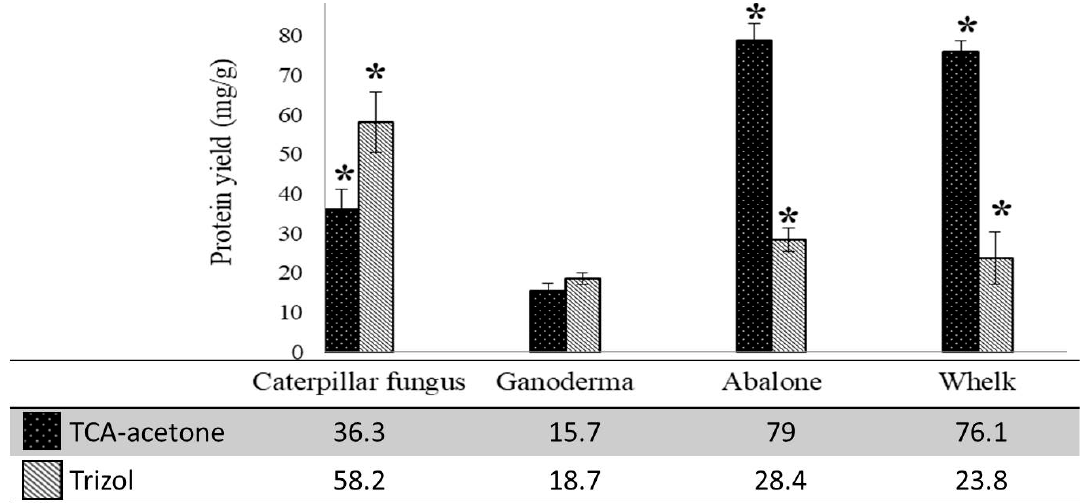
Figure 1. The comparisons of protein yields of caterpillar fungus, ganoderma, abalone, and whelk samples prepared by trichloroacetic acid (TCA)-acetone precipitation and TRIzol extraction methods. Results were the average of values from three independent experiments. * indicates significant difference ( p ≤ 0.05) between two